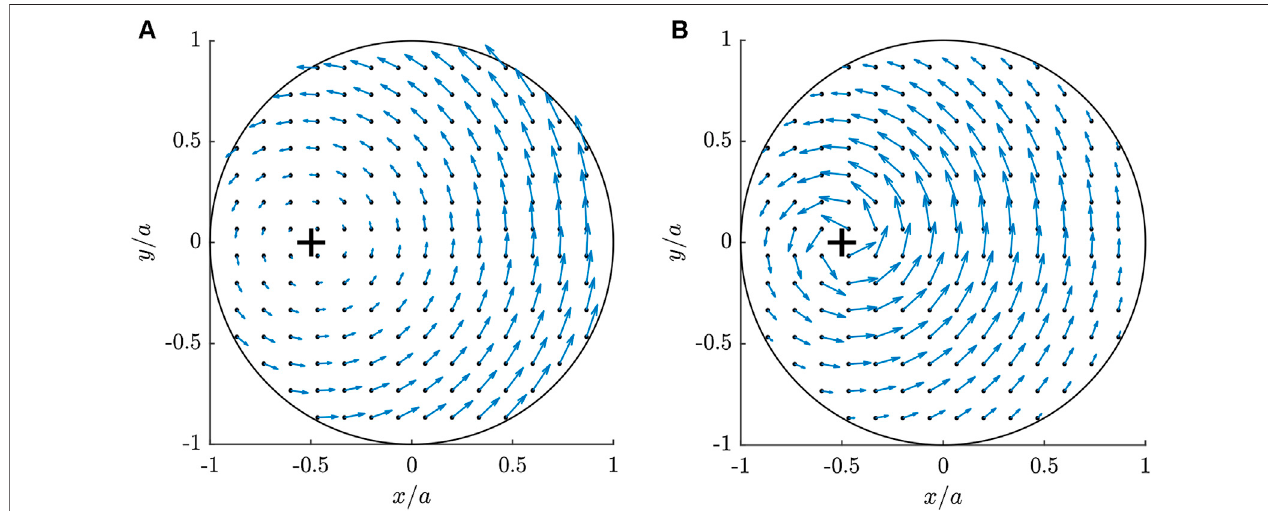
FIGURE 3 | Hertzian indenter slipped in positive y -direction and rotated. Normalized forward speed ~ v (cid:2) 0 . 5. Quiver plots of (A) local velocity fi eld, (B) tangential surface stresses. The stress vector fi eld also rotates around x / a (cid:2) − 0 . 5 but its amplitude is related to the contact pressure.